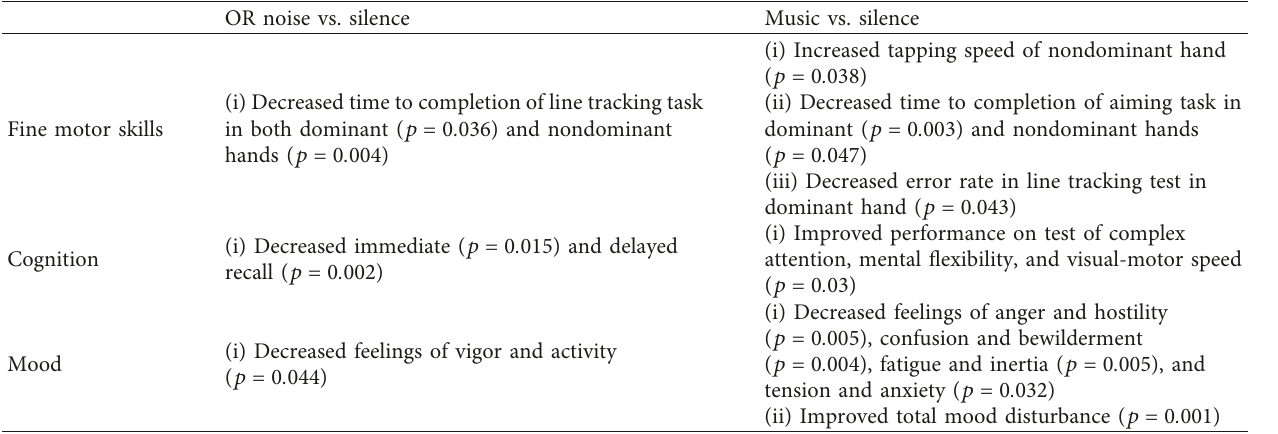
Table 1: Significant differences in tests of fine motor skills, cognition, and mood in the various noise conditions. OR noise vs.